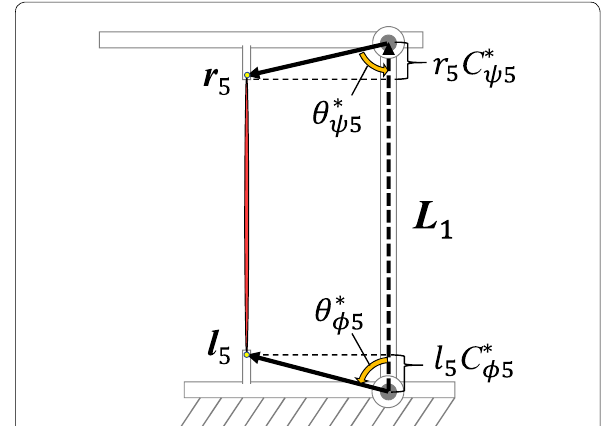
Fig. 15 Geometric relationship of the parameter Z 5